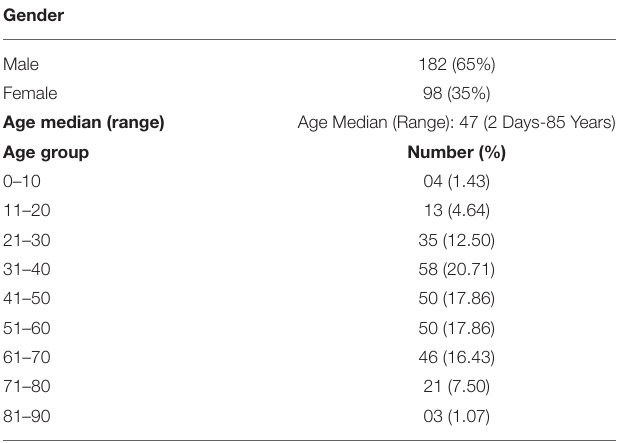
TABLE 1 | Demographics and baseline characteristics of enrolled